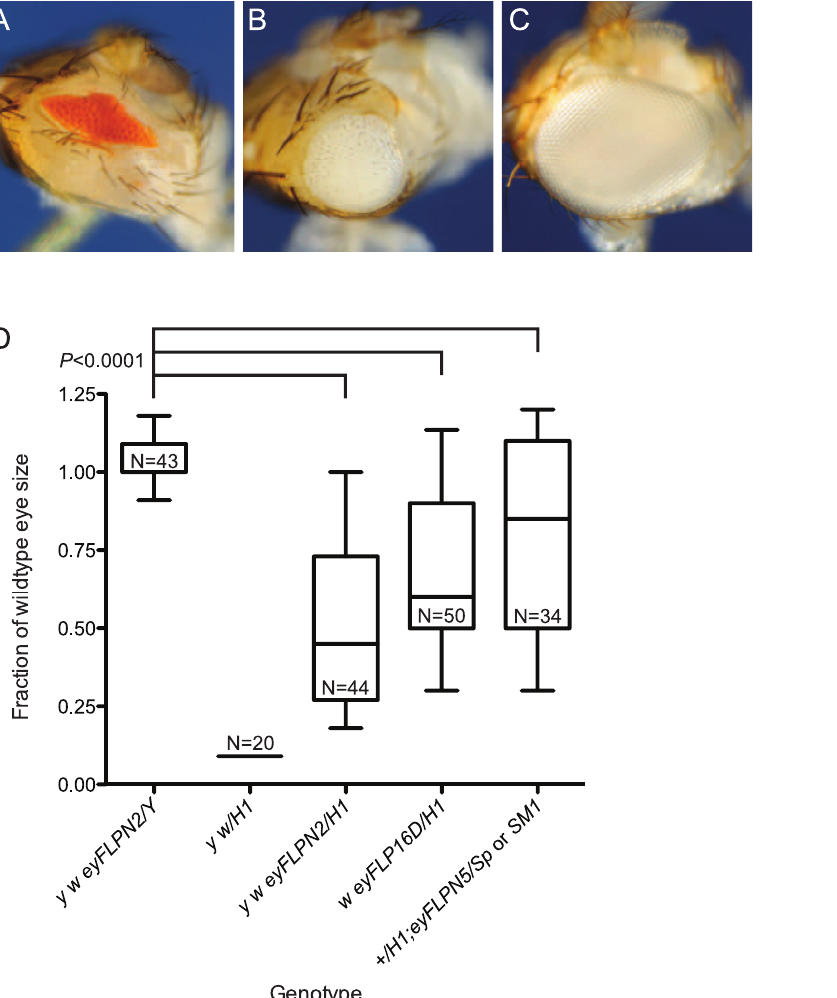
Figure 2. The effect of telomere loss on cell survival in the eye using the BARTL assay. Representative eye phenotypes are pictured. (A) The B S phenotype of y w/DcY ( H1 ) in the absence of FLP. (B) y w {eyFLP.N}2/DcY ( H1 ) eyes that have experienced telomere and B S loss are larger than B S but smaller than wildtype eyes. (C) The y w {eyFLP.N}2/Y eyes used as controls are indistinguishable from wild type with respect to size and morphology. (D) The effect of three different eyFLP s combined with DcY ( H1 ) are shown. Distribution of eye sizes are represented using box-and- whisker plots. Genotypes are indicated on the x-axis and eye size (area normalized to wildtype eye) is on the y-axis. The ends of the whiskers represent the 5 th and 95 th percentiles; the top and the bottom of the boxes represent the 25 th and 75 th percentiles of the range of eye sizes; the median (50 th percentile) is represented by the horizontal line in the box. N is the number of eyes measured. Significance levels for critical comparisons are indicated.